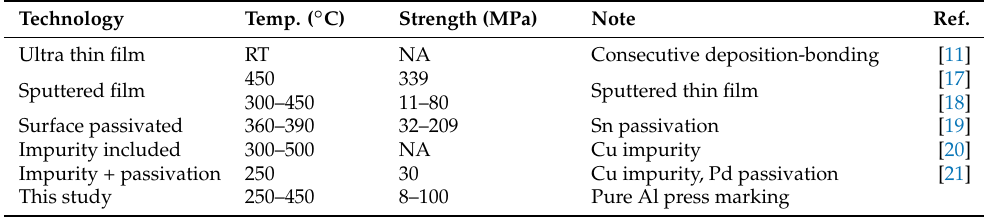
Table 2. Comparison with the state-of-the-art Al wafer bonding technologies.